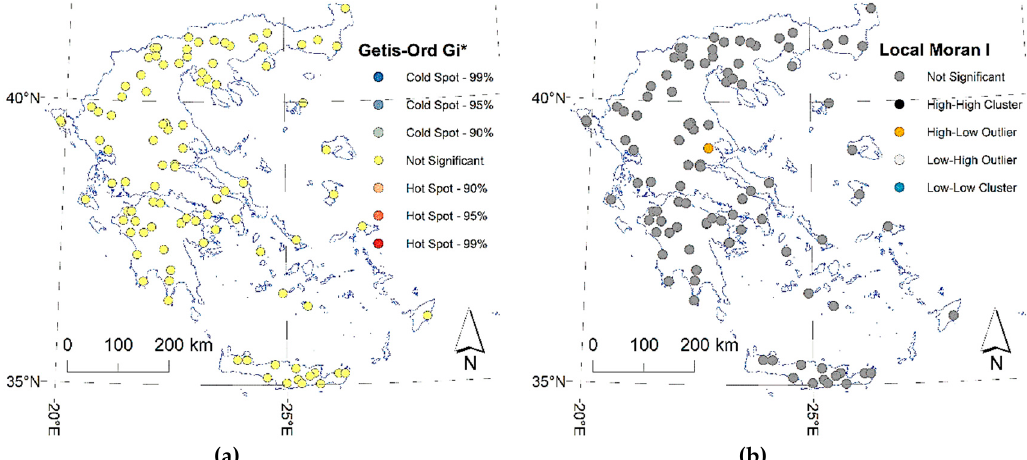
Figure 5. Spatial independence of gully length visualized: ( a ) at the global scale using the Getis-Ord Gi* statistic (percentages indicate level of confidence); and ( b ) at the local scale using Anselin Local Moran’s I statistic.